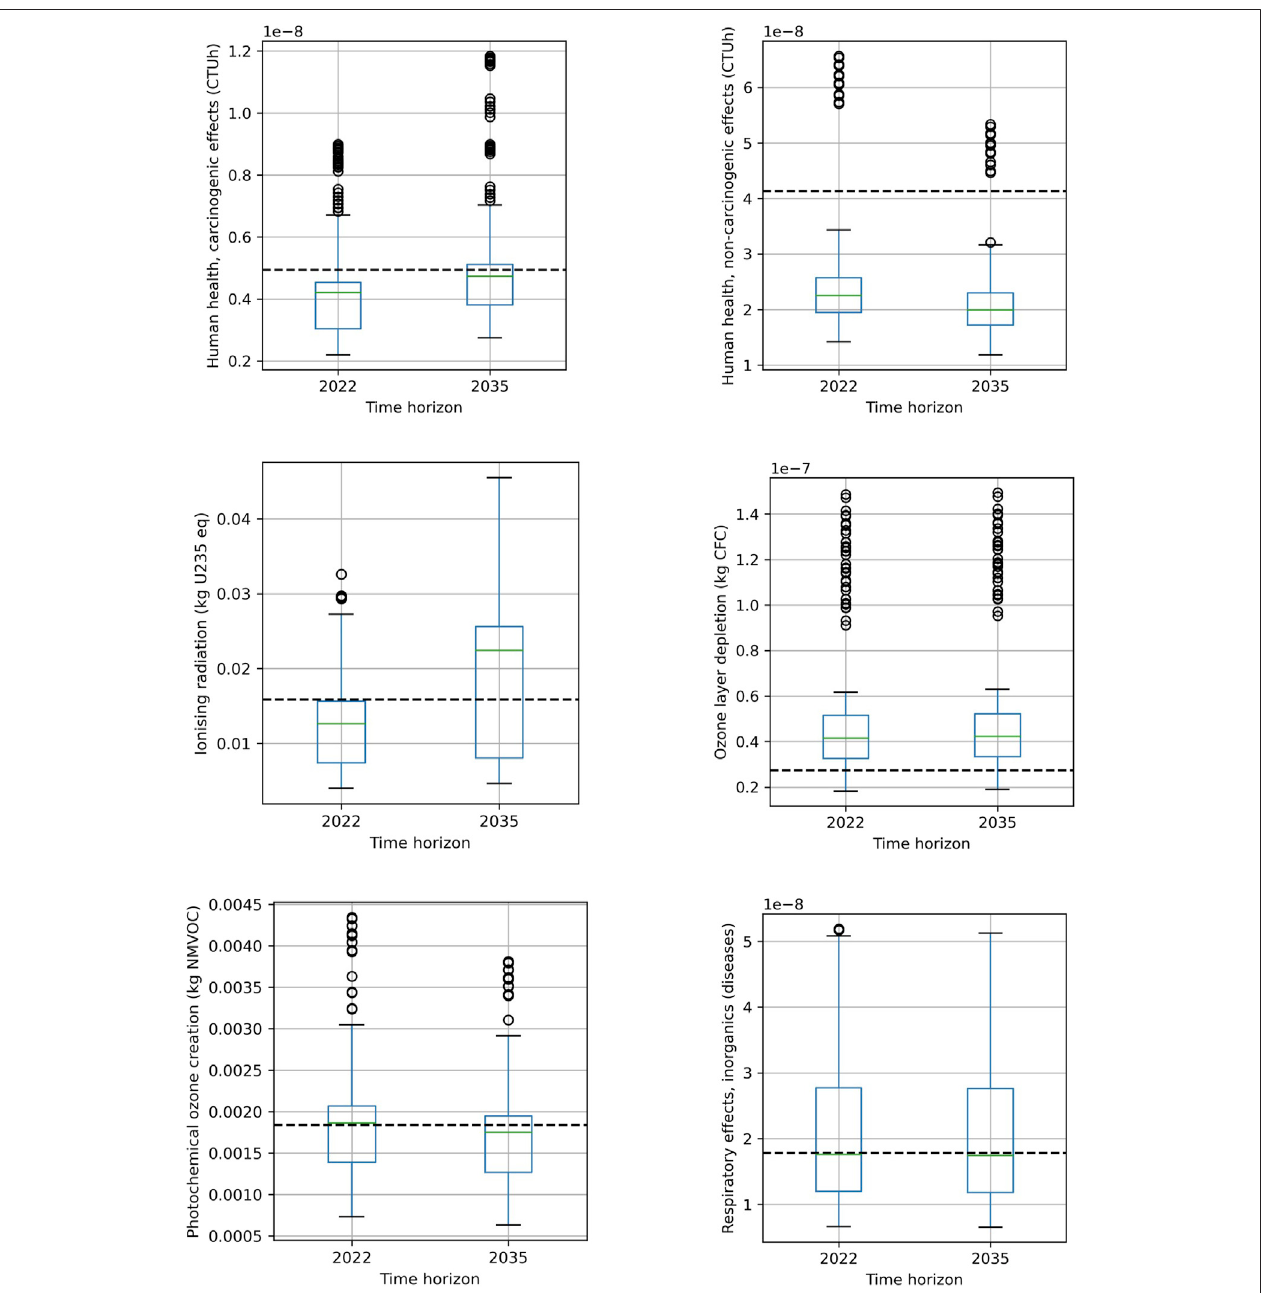
FIGURE 4 | Scenarios distribution for midpoint impacts on human health with the two production time-horizons — the dashed line shows the impact of 1 kg of Portland cement.